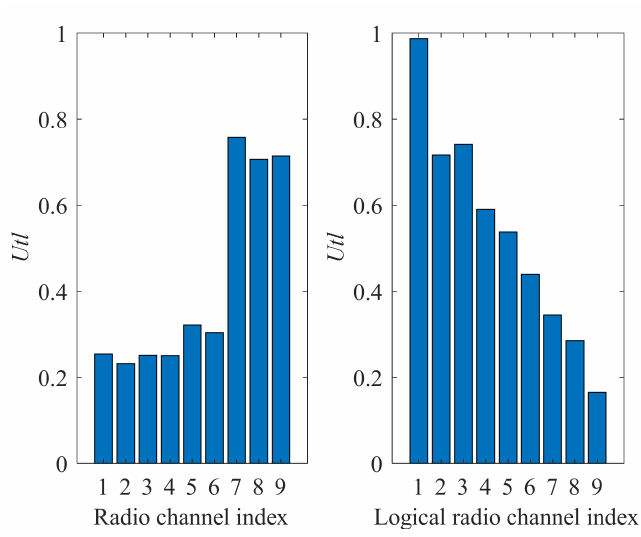
Figure 13. Utility ratio ( Utl ) values for physical radio channels (on the left ) and logical radio channels selected by the proposed algorithm (on the right ).